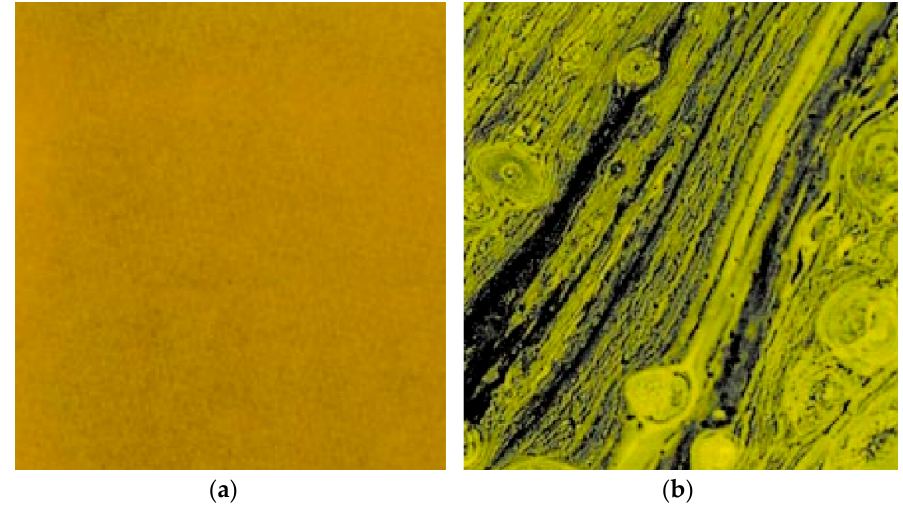
Figure 7. ( a ) A compatible system with 4% SBS and ( b ) an incompatible system with 4% of SBS content (reprinted from the Shell Bitumen Industrial Handbook with permission of SHELL Publisher).